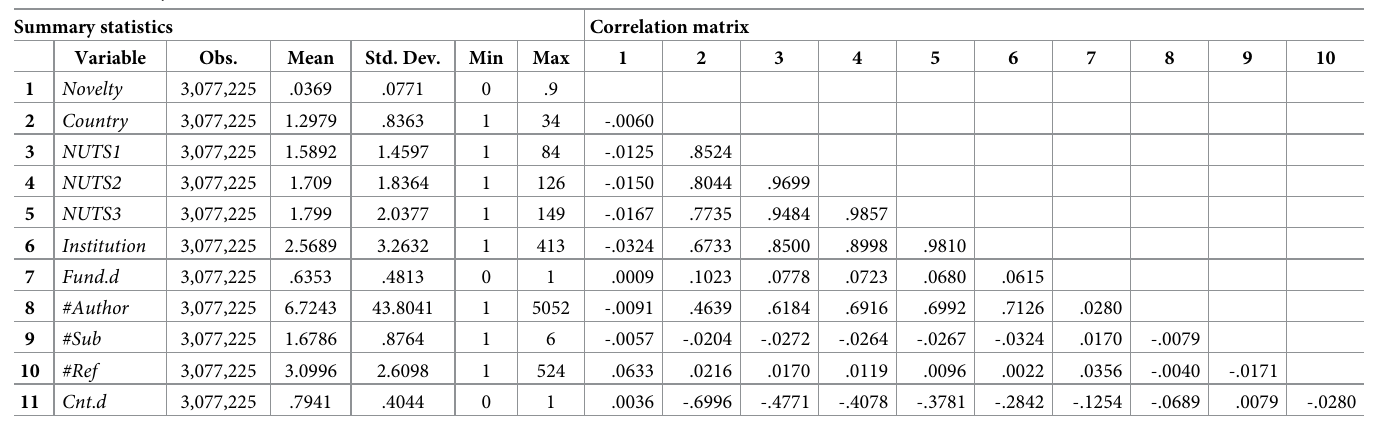
Table 1. Summary statistics.